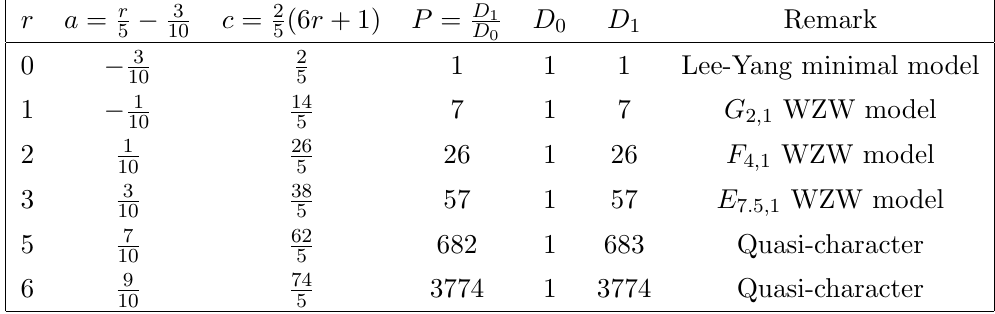
Table 3 . The Lee-Yang series (Multiplicity M = 1).